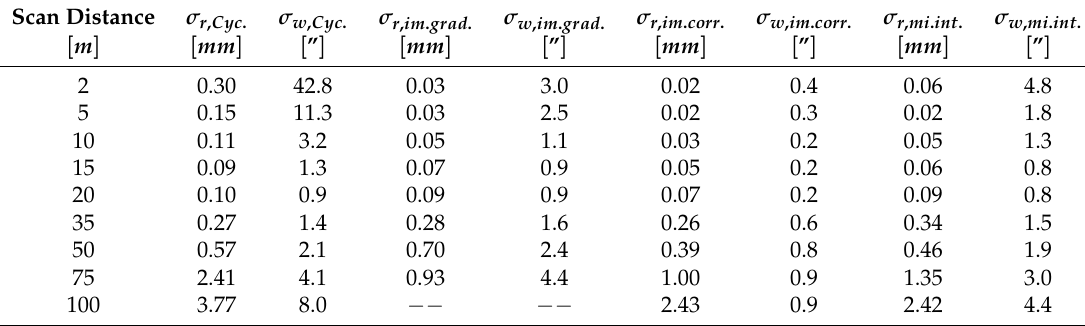
Table 2. Empirical standard deviations in distance direction ˆ σ r and angular direction ˆ σ w for each algorithm (Cyc.: Cyclone, im.grad.: image gradients, im.corr.: image correlations, mi.int.: middle intensities). Scan